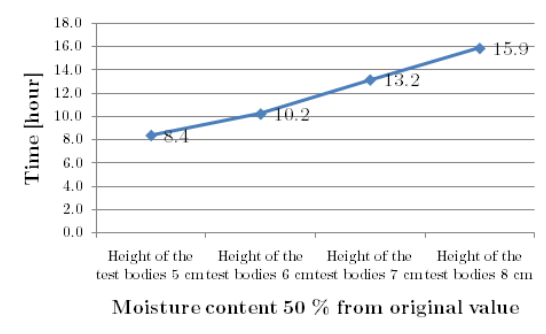
Figure 15. The decrease by 85 % from original value of the moisture content – linear